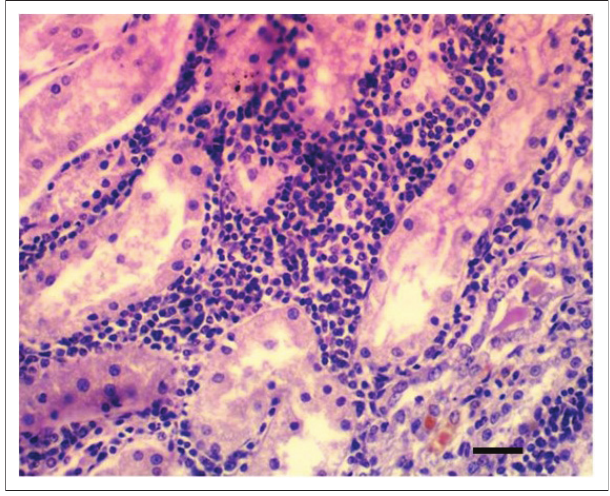
FIGURE 4: Kidney section of antelope showing immunoreactivity of Leptospira interrogans serovar hardjo antigen in the tubular lumen (arrows).